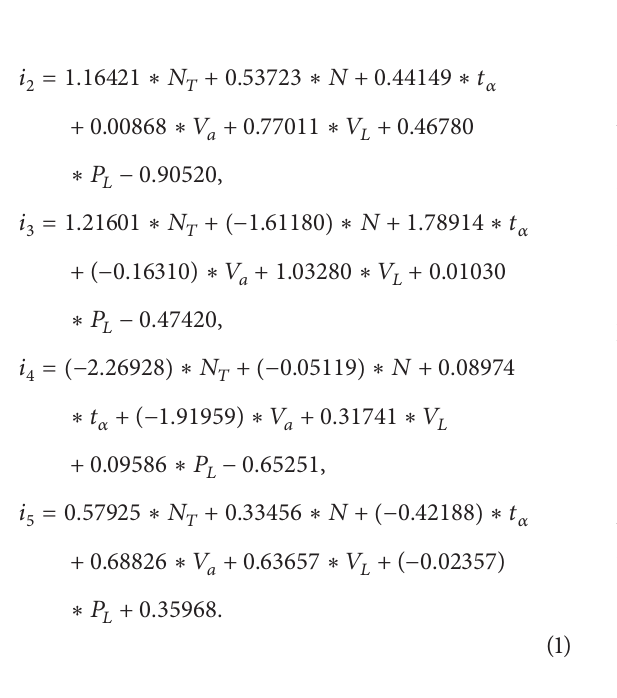
Figure 12: The correlation of output of power generated with predicted power generated on data training (a), data test (b), data validation (c), and data overall